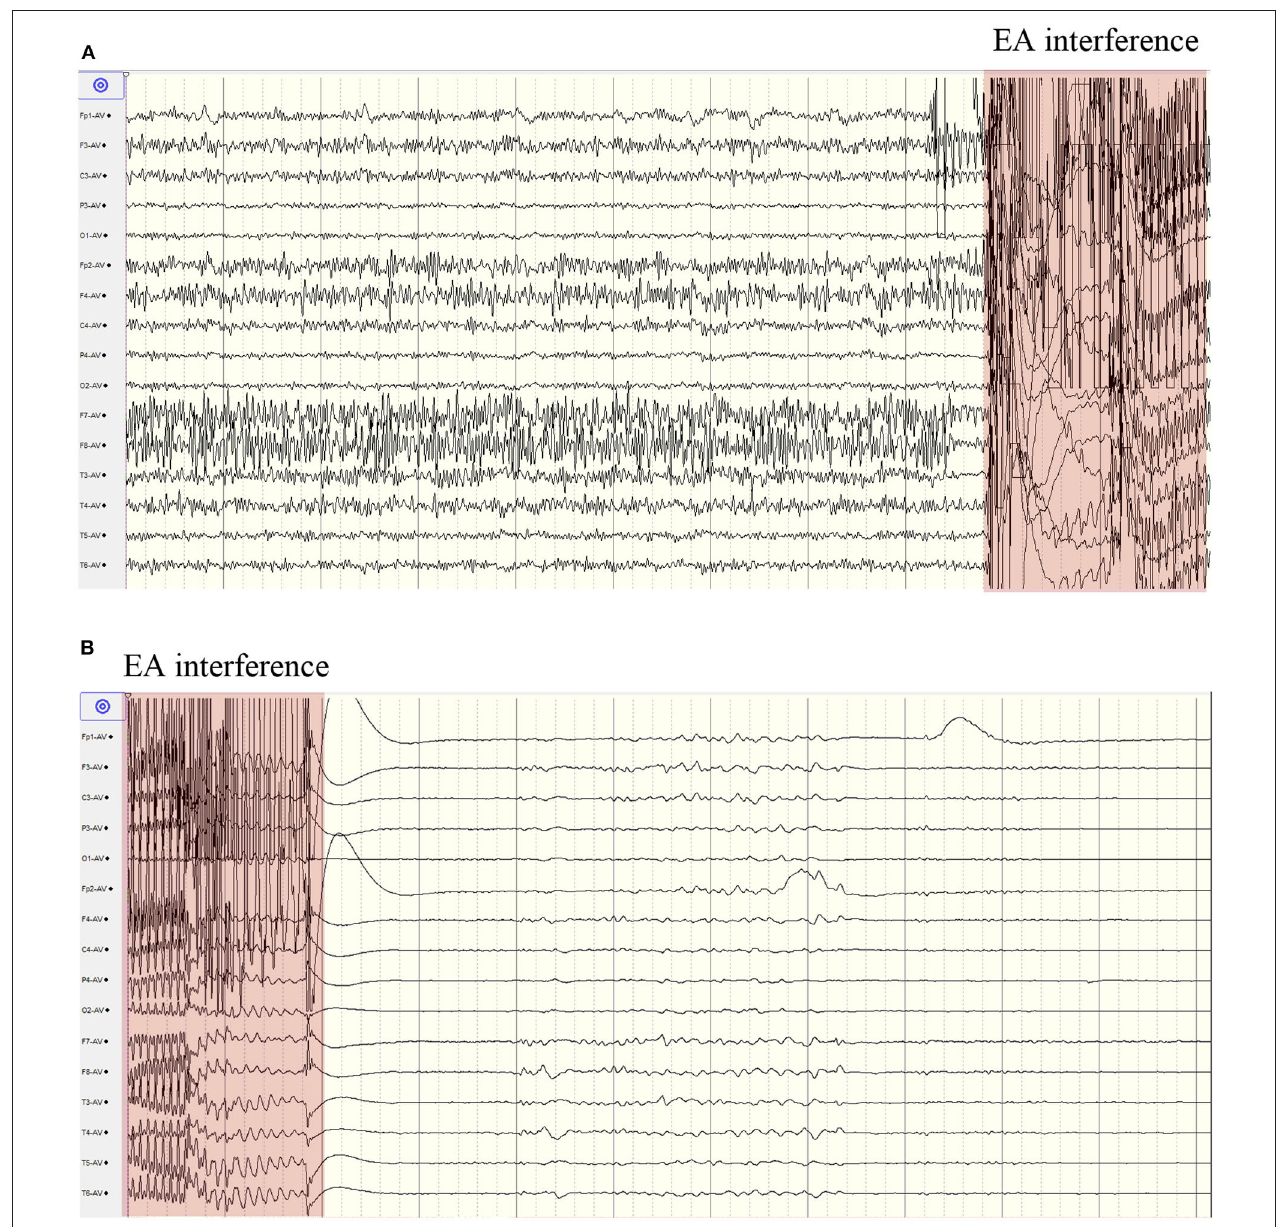
FIGURE 3 | Continuous scalp EEG recording before and after electroacupuncture. (A) epileptic discharges before electroacupuncture; (B) EEG suppression after electroacupuncture. EA,